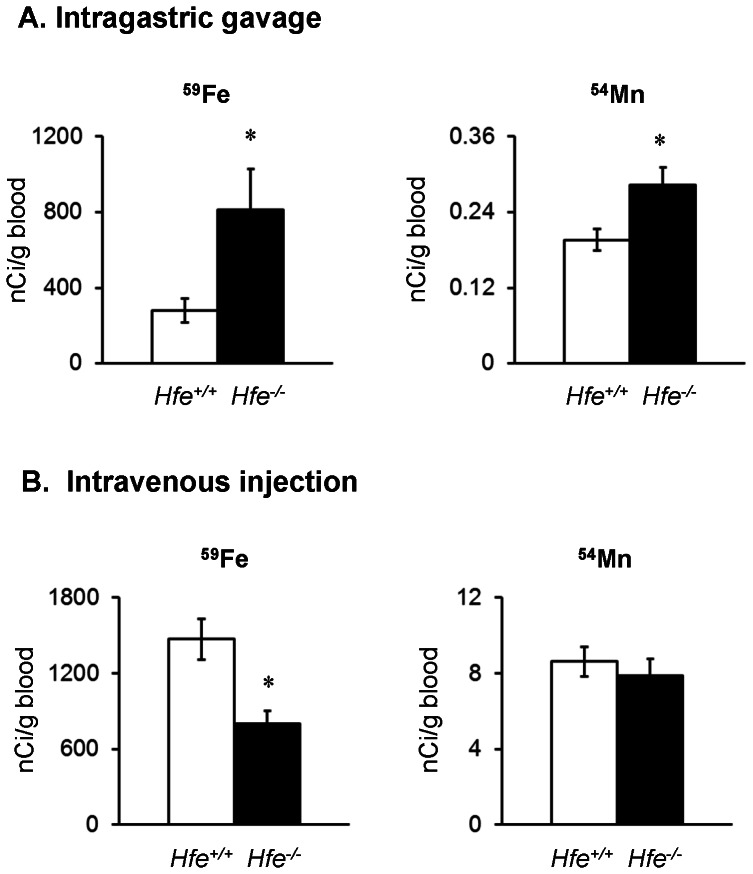
Effect of HFE deficiency on absorption of 59Fe and 54Mn after intragastric gavage and intravenous injection.Blood levels of 59Fe as nCi/g blood were characterized 4 h post-dose of 59FeCl3 (200 µCi/kg body weight) to mice by intragastric gavage (A) and intravenous injection (B). Empty and closed bars represent Hfe
+/+ and Hfe
−/− mice, respectively. Data were presented as mean ± SEM (n = 4–5 per group). Blood levels of 54Mn as nCi/g blood were characterized 1 h post-dose of 54MnCl2 (200 µCi/kg body weight) to mice by intragastric gavage (A) and intravenous injection (B). Data were presented as means ± SEM (n = 4–10 per group). * P<0.05 between Hfe
+/+ and Hfe
−/− mice determined by two-sample t-test.